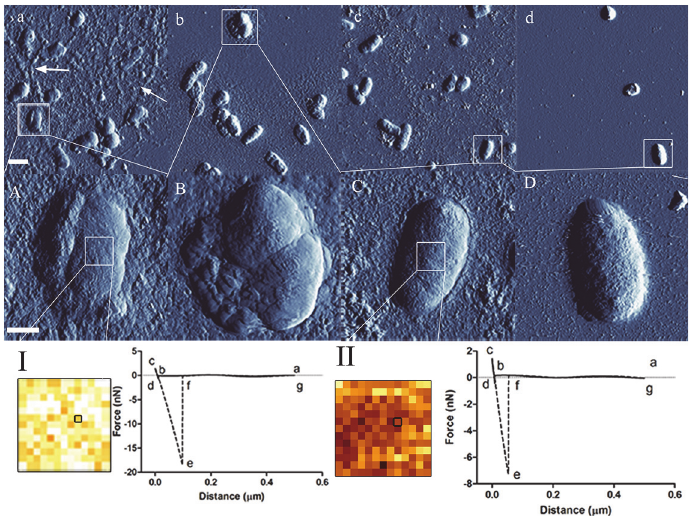
Fig 2. AFM and QI images with force curves illustrate cell surface remodelling with 2,4-D exposure. Rlv treated with 0.4 mM (a, A), 0.2 mM (b, B) 2,4-D have markedly altered surfaces compared to those of formula (c, C) and sample controls (d, D). Arrows indicate extracellular matrix on the substrate surface, only observed for Rlv treated with 2,4-D. Images a-d are low resolution (300 × 300) and A-D are high resolution (500 × 500). Scale bars, a-d = 1 μ m, A-D = 0.5 μ m. I and II show quantitative imaging data and representative force curves corresponding to one pixel at the center of the cell surface adhesion map for treated and control samples, respectively. From the force curves (a-c extend, c-g retract) the e-f segment is used to measure the adhesion force and b-c used to calculate Young ’ s moduli. QI adhesion maps indicated that treated cells had a much higher (lighter pixels) tip adhesion than the control (darker